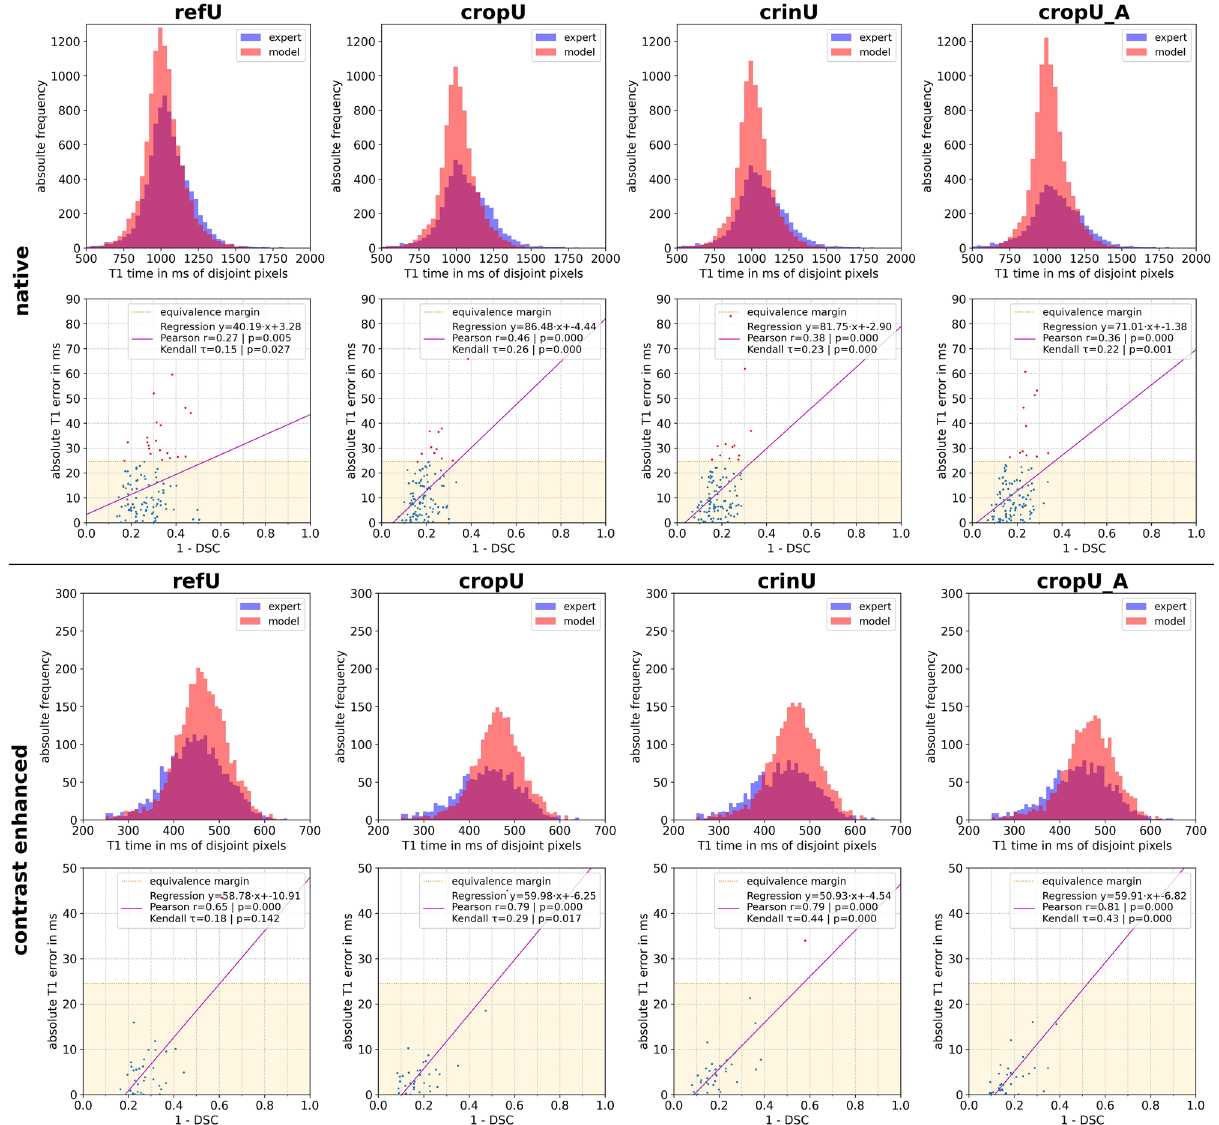
cases exceeding the equivalence